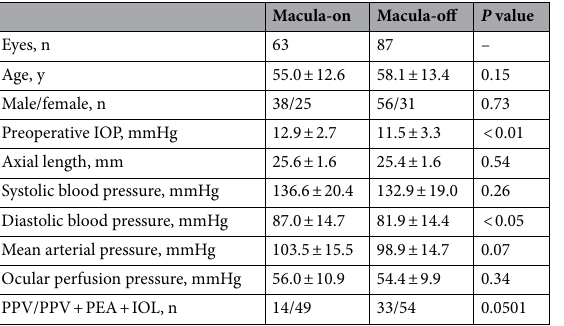
Table 1. Clinical characteristics of participants. Values are mean ± SEM unless stated otherwise. IOP intraocular pressure, PPV pars plana vitrectomy, PEA phacoemulsification and aspiration, IOL intraocular